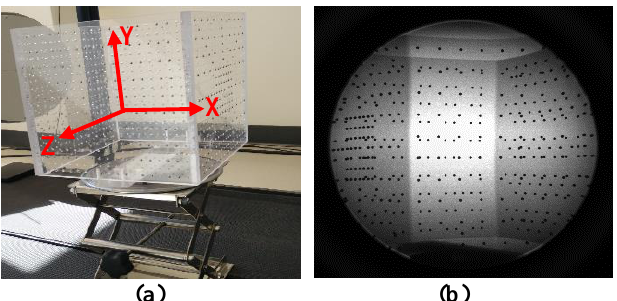
Figure 3. Calibration frame images, (a) optical image and (b)